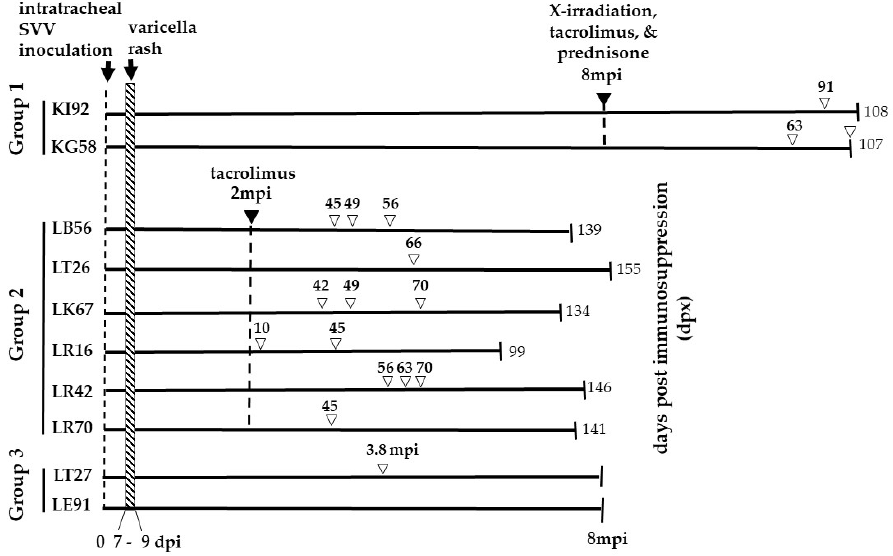
Figure 1. Experimental Design. The monkeys were divided into three groups. Two rhesus macaques (Group 1—KI92 and KG58) were intratracheally inoculated with 5 × 10 5 pfu of SVV and developed varicella rash 7–9 days post-inoculation (dpi). Eight months’ post-inoculation (mpi), both monkeys were exposed to X-irradiation (200 cGy) and daily oral treatment with tacrolimus (80 μg/kg/day) and prednisone (1 mg/kg/day) for the duration of the experiment. KI92 and KG58 developed zoster rash, 91- and 63-days post-immunosuppression treatment (dpx), respectively. KG58 had recurrent zoster at 107 dpx. KI92 and KG58 were euthanized 108 and 107 dpx, respectively. Six rhesus macaques (group 2—LB56, LT26, LK67, LR16, LR42, and LR70) were intratracheally inoculated with 2.4 × 10 5 pfu SVV, and all developed varicella rash between 7–9 dpi. Two months later, all six monkeys were treated with tacrolimus (80 µ g/kg/day) daily for the duration of the experiment. All six immunosuppressed monkeys developed a zoster rash at indicated dpx (numbers above, unfilled arrowheads). Monkeys LB56, LK67, LR16, and LR42 had recurrent zoster, as indicated by multiple unfilled arrowheads. All six monkeys were euthanized at the indicated dpx. Two rhesus macaques (group 3—LT27 and LE91) were intratracheally inoculated with 2.4 × 10 5 pfu of SVV, and both developed varicella rash by nine dpi. Neither were immunosuppressed. One of the monkeys (LT27) developed zoster rash 3.8 mpi. Group 3 monkeys were euthanized 8 mpi. DNA extracted from skin scrapings obtained at the time of zoster from monkeys in all three groups were analyzed for the presence of SVV DNA by qPCR. Euthanasia is indicated by vertical lines on the right end of the lines. The numbers at the end of the lines indicate the time (dpx (groups 1–2) or mpi (group 3)) of euthanasia.